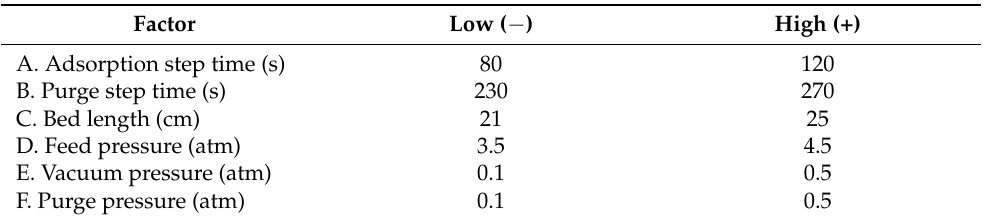
Table 7. The high- and low-level setting values for each factor in